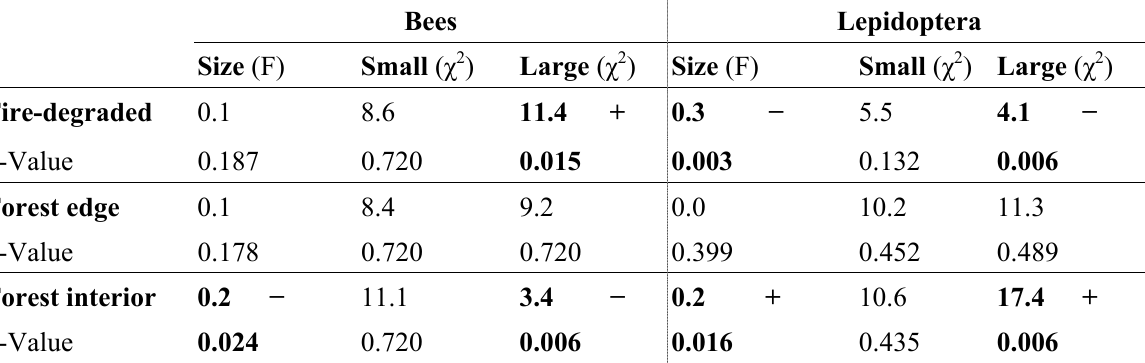
Table 2. Fourth-corner analyses of body sizes of two pollinator guilds (bees and butterflies/moths) along a human-induced habitat gradient comprising forest interior, forest edge and fire-degraded habitats. Non-random distribution of body sizes was tested using F- and χ 2 -statistics in permutation model 1 [35]. Holm's corrected p -values are provided; significant p -values ( p < 0.05) are printed in bold. Effect sizes that indicate an increase or decrease of body size in the respective habitat type are indicated by "+" and "–", respectively. Bees Lepidoptera Size (F) Small ( χ 2 ) Large ( χ 2 ) Size (F) Small ( χ 2 ) Large ( χ 2 )